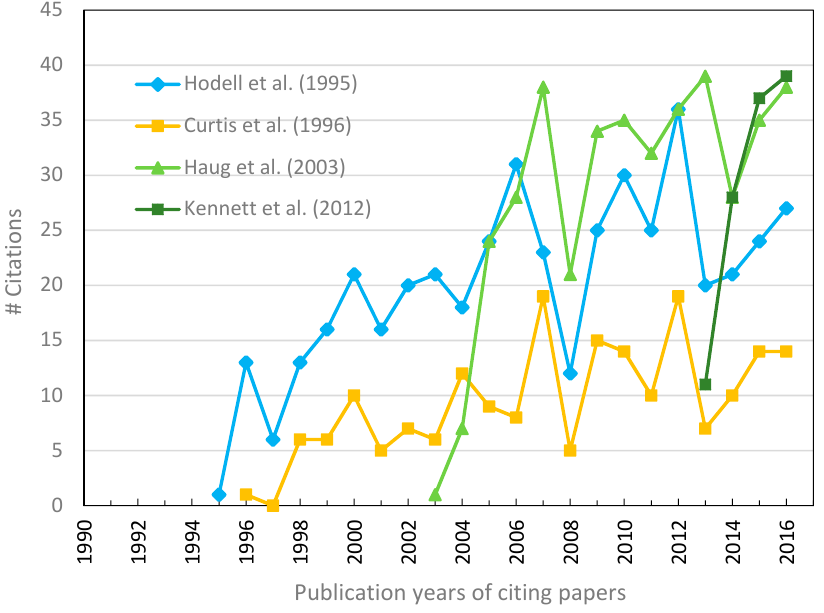
Figure 8. Time-evolution of the number of citations per year of four key-papers. Source: WoS.